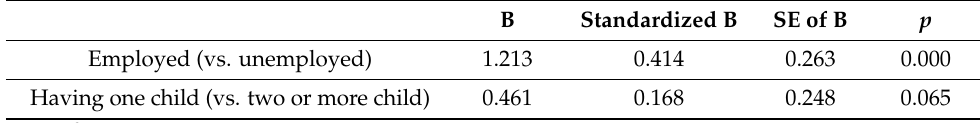
Table 7. Adjusted effects on Prolonged Sedentary Time in the final model.